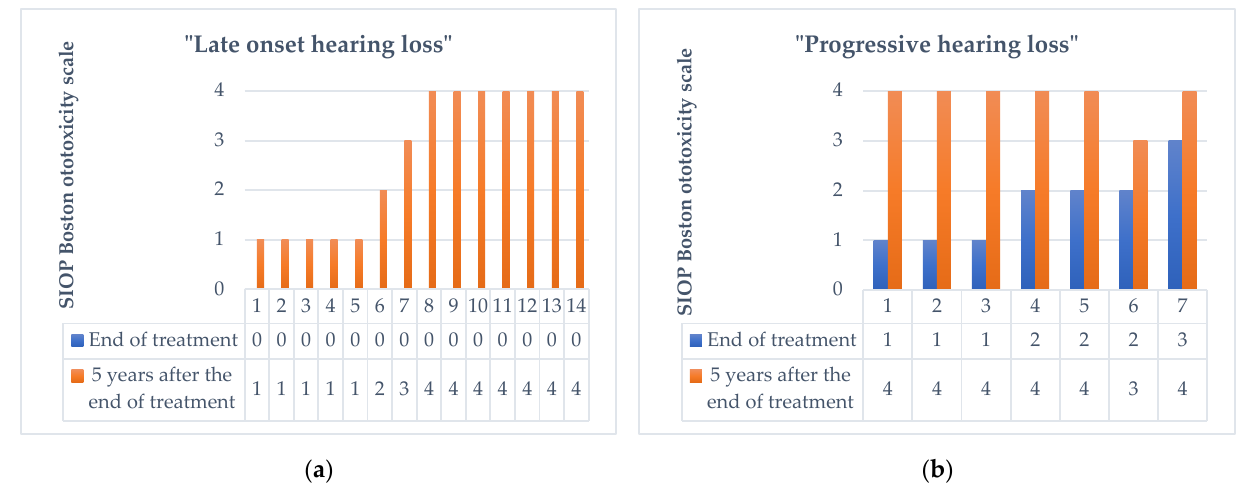
Figure 2. Change in the degree of ototoxicity according to the SIOP Boston Ototoxicity Scale 5 years after the end of therapy in 21 patients with late onset hearing loss ( a ), and progressive hearing loss ( b ). Five years after the end of the therapy, the number of patients with late-onset hear- ing loss/progressive hearing loss who had undergone radiotherapy was 13, statistically different from those with stable hearing ( p = 0.007).